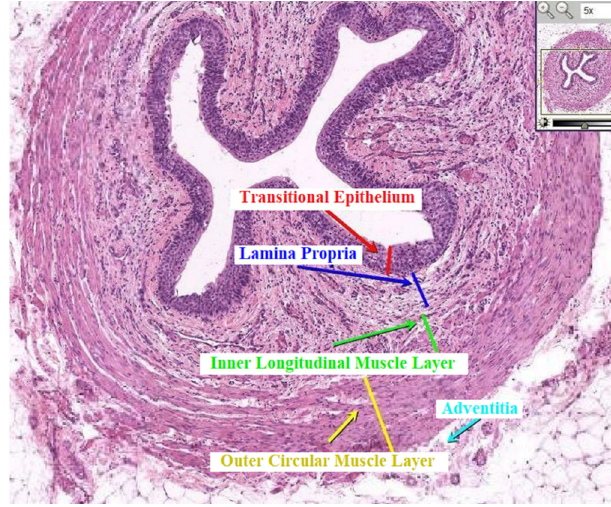
Figure 1. Histological section of human urethral sphincter.